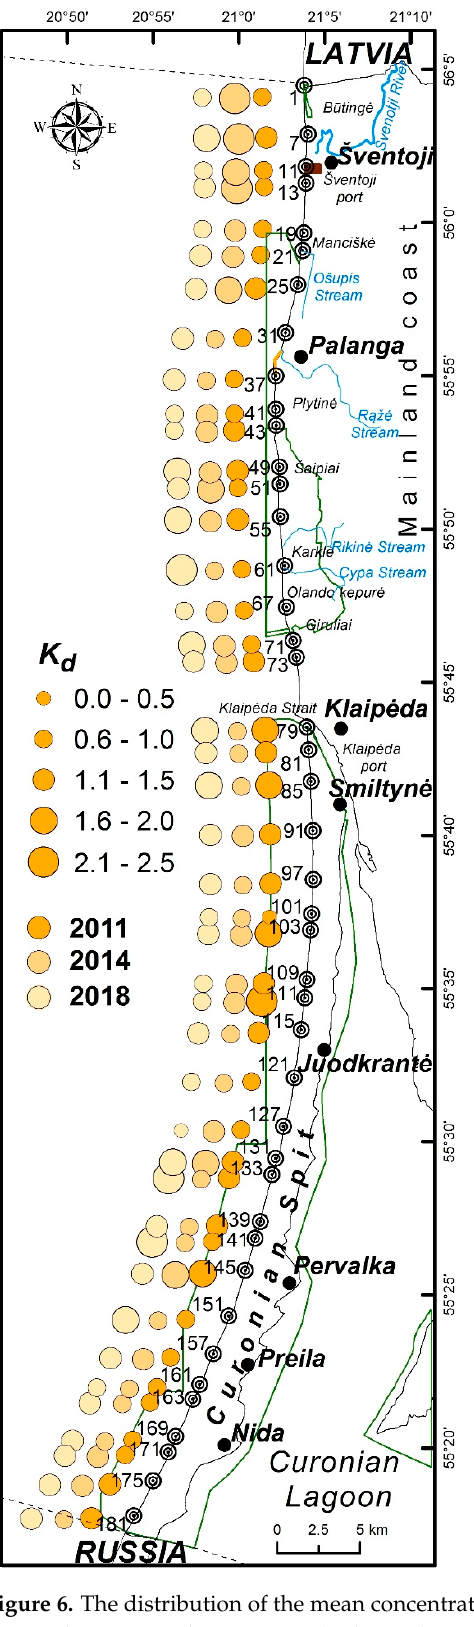
Figure 6. The distribution of the mean concentration ratio ( K d ) of all analysed trace elements along the south-eastern Baltic Sea coast (Lithuania).